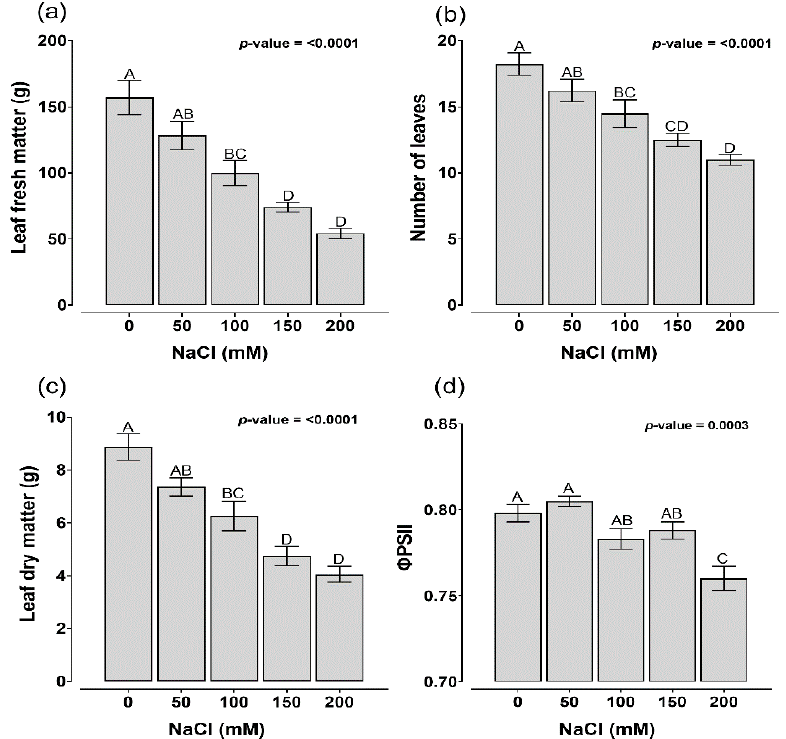
Figure 1. Production of fresh leaf matter ( a ), dry leaf matter ( b ), number of leaves ( c ), and efficiency of photosystem II ( Φ PSII) ( d ) in red lettuce plants ( Lactuca sativa Lollo Rosso cv. ‘CARMOLI’) growing at increasing NaCl concentrations in a hydroponic system. Different letters indicate significant differences ( p < 0.05), according to the Tukey multiple range test ( p < 0.05) following ANOVA. Data are expressed as mean ± SE, n = 6.